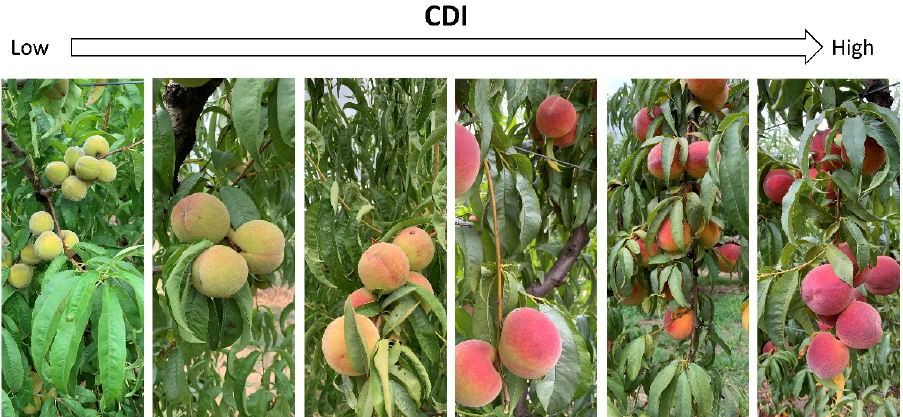
Figure 1. CieLAB colour space and representation of hue angle (h°) and Colour Development Index (CDI) values around the colour wheel (adapted with permission from Scalisi et al. [8]).